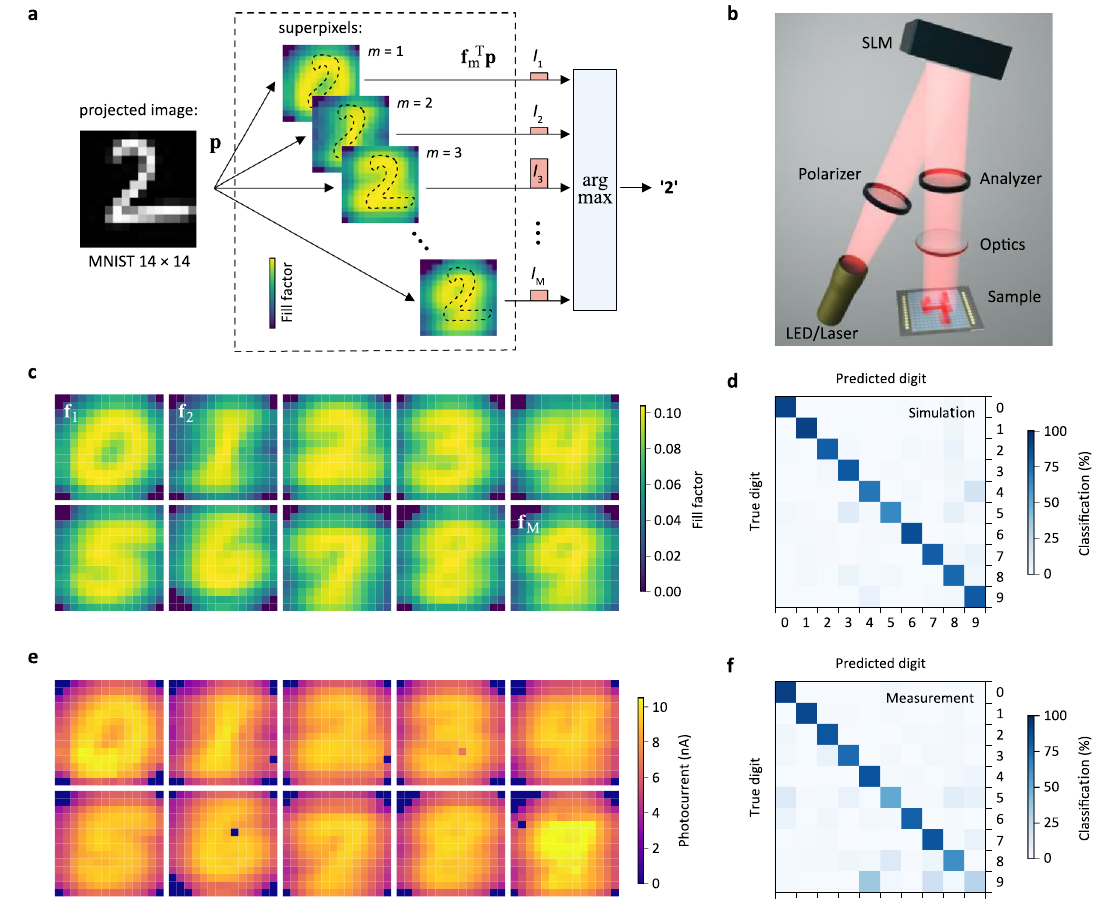
Figure 3. Naïve Bayes photosensor. ( a ) Schematic illustration of the working principle. An image from the MNIST dataset is projected onto the chip and detected by each superpixel. The channel with the largest output current is selected. We perform this operation in the digital domain; in the analogue it could be realized by a winner-take-all circuit 23 . ( b ) Sketch of the experimental setup. ( c ) Superpixel shapes for the NB classifier as determined from the MNIST training dataset. ( d ) Calculated confusion matrix. ( e ) Measured photoresponsivity maps. ( f ). The experimental confusion matrix was determined by optical projection of 10 4 digits, one after the other, and comparison of the known/true class labels with the labels predicted by the sensor (channel with highest output